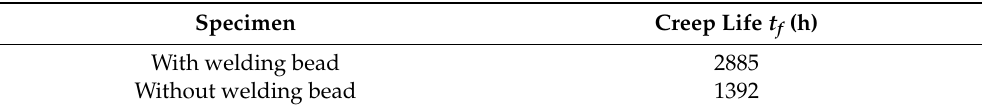
Figure 7. Variation of displacement with time for a specimen with a defect ratio of 33%.